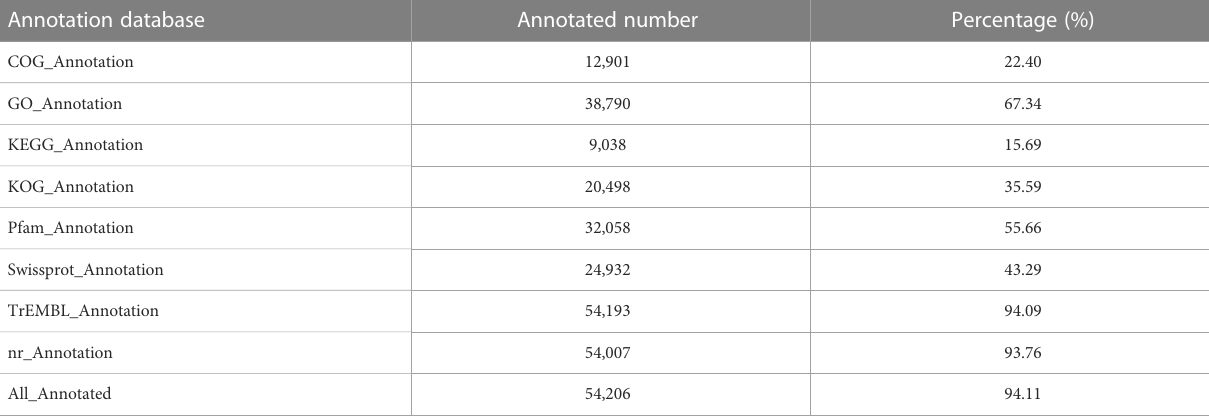
TABLE 5 The statistics information of the annotated